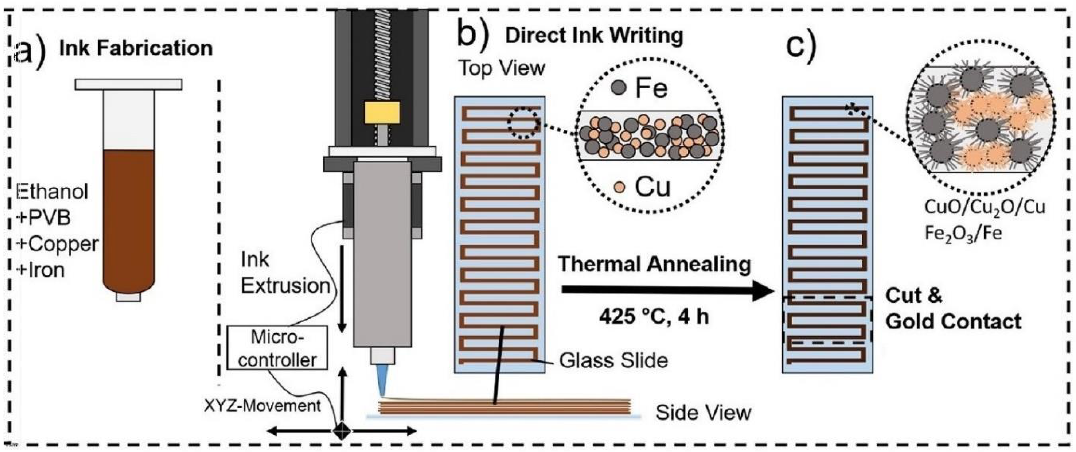
Figure 9. ( a – c ) Different steps for preparation of CuO/Fe 2 O 3 gas sensor using direct ink writing